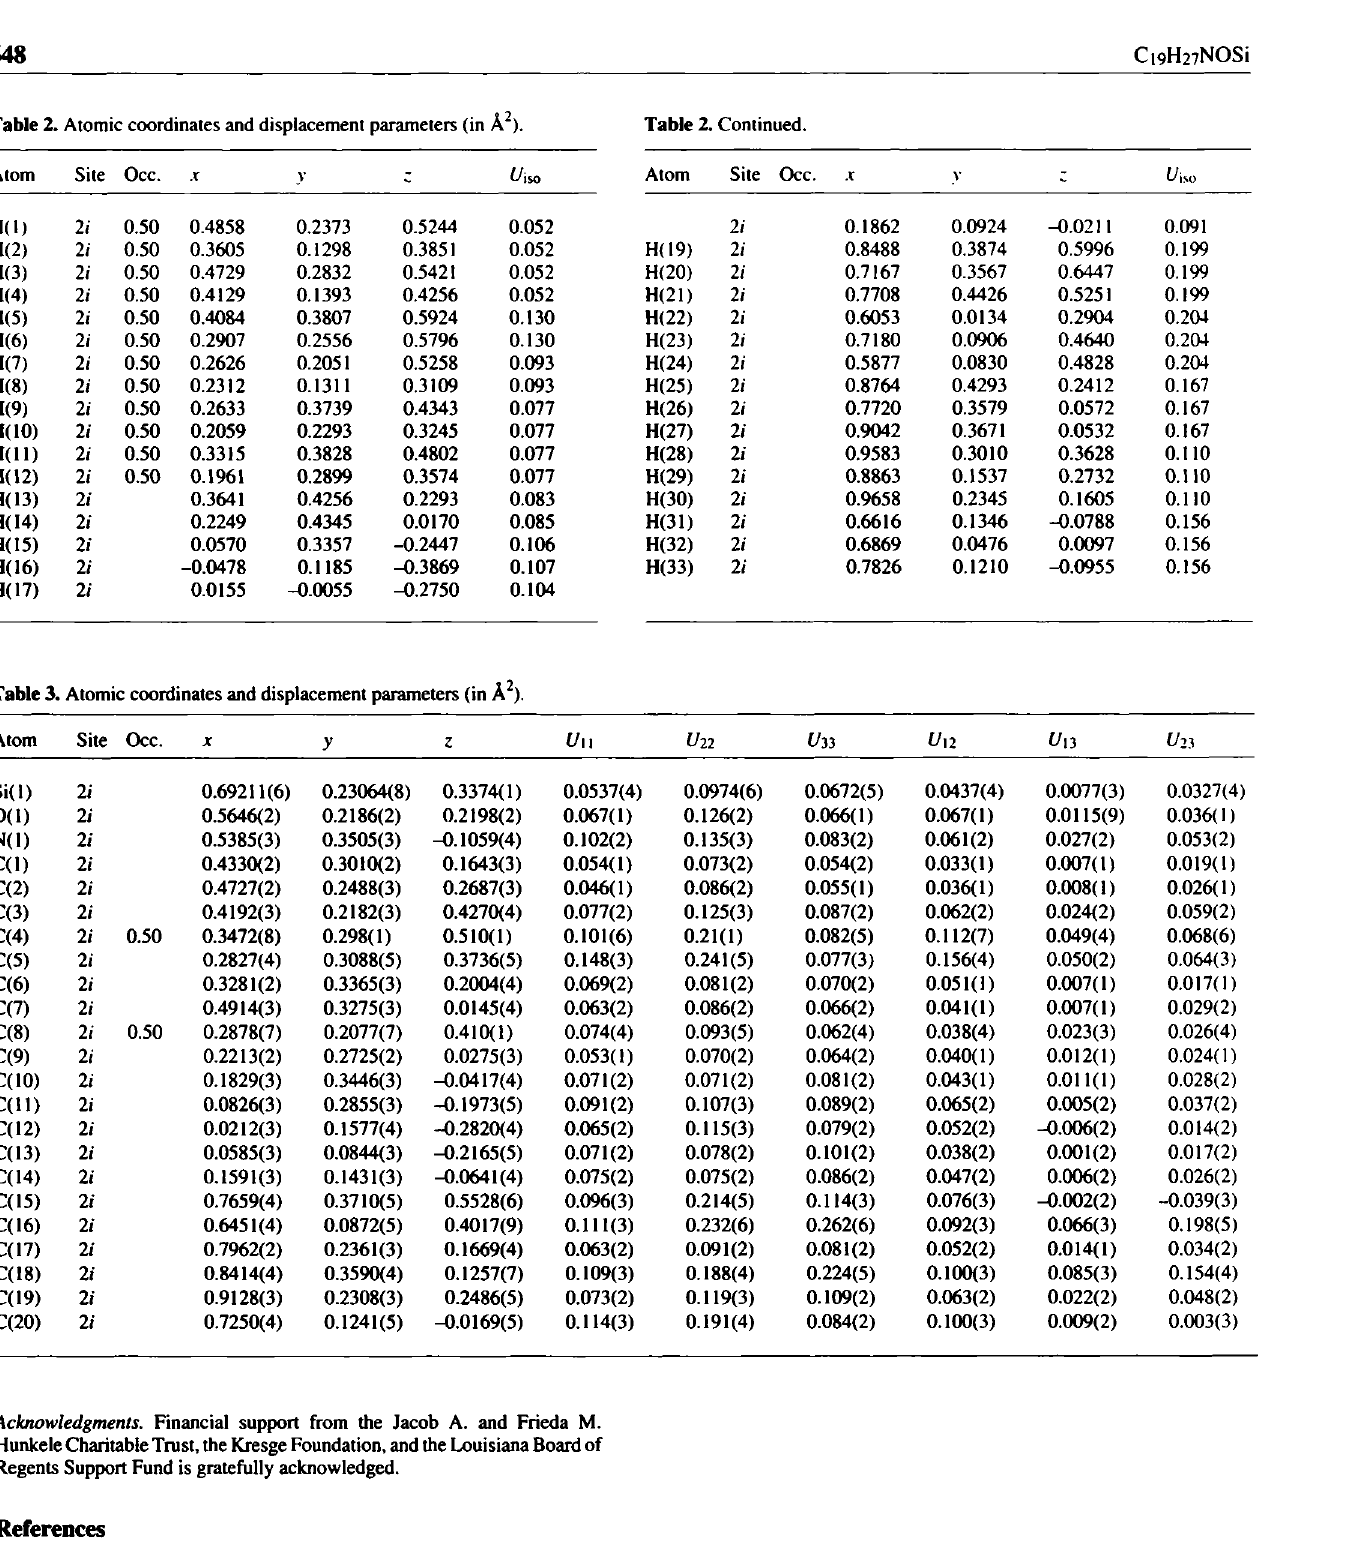
Table 2. Atomic coordinates and displacement parameters (in Ä 2 ).